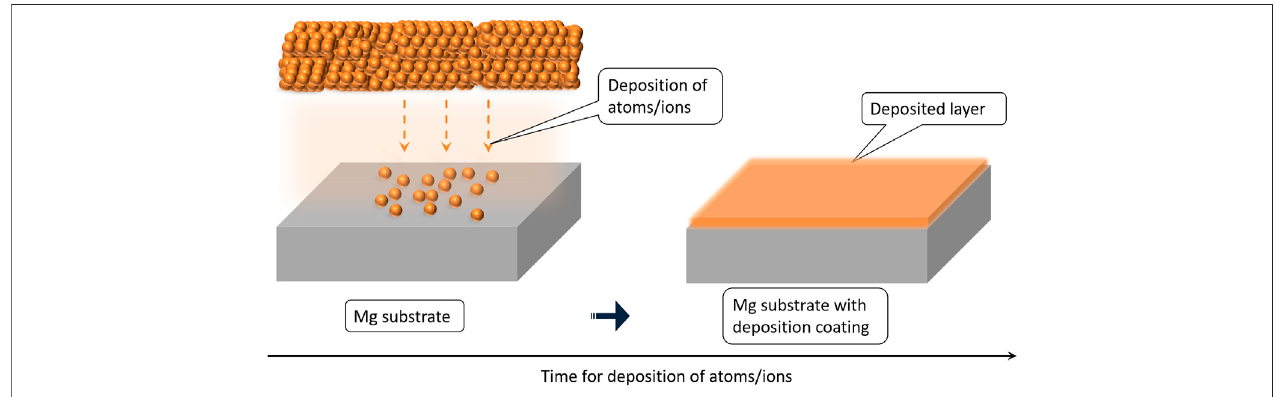
FIGURE 5 | Schematic representation of physical deposition